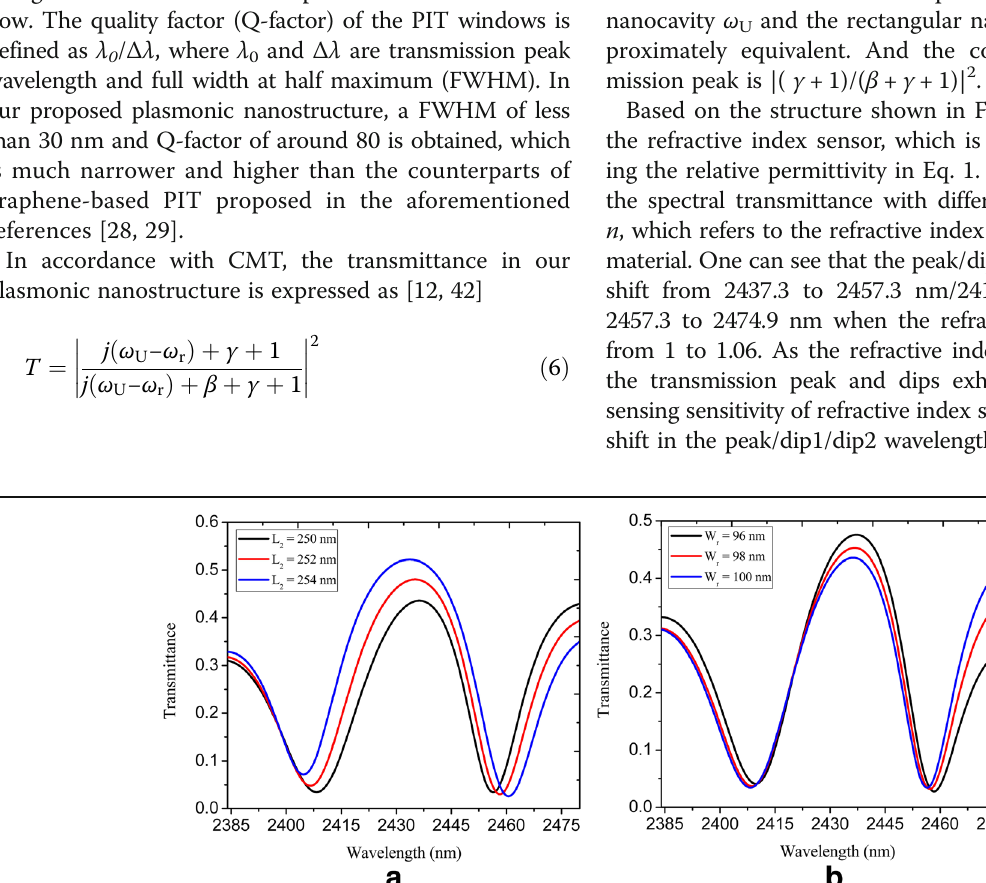
Fig. 5 Spectral transmittance of U-shaped and rectangular nanocavity-coupled waveguide system shown in Fig. 3: a with L 2 = 250, 252, and 254 nm; b with W r = 96, 98, and 100